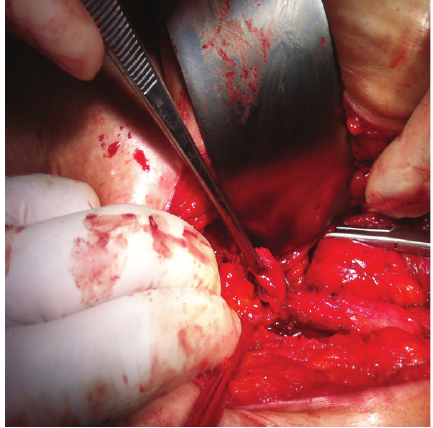
Figure 3: Intraoperatively a kinking of the ureter like an Omega shape because of the suturing is